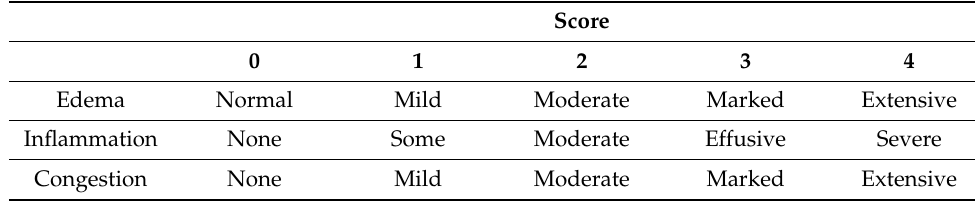
Table 3. Histopathologic scoring